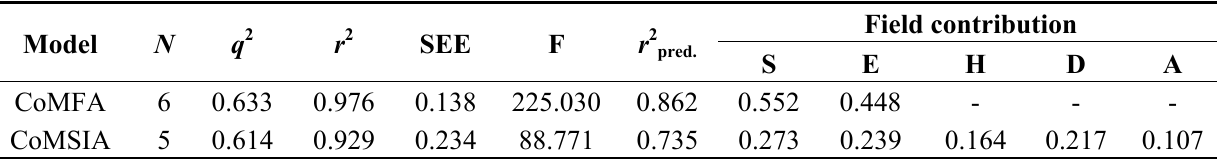
Table 1. The statistical results of comparative molecular similarity indices analysis (CoMSIA) and comparative molecular field analysis (CoMFA) models.